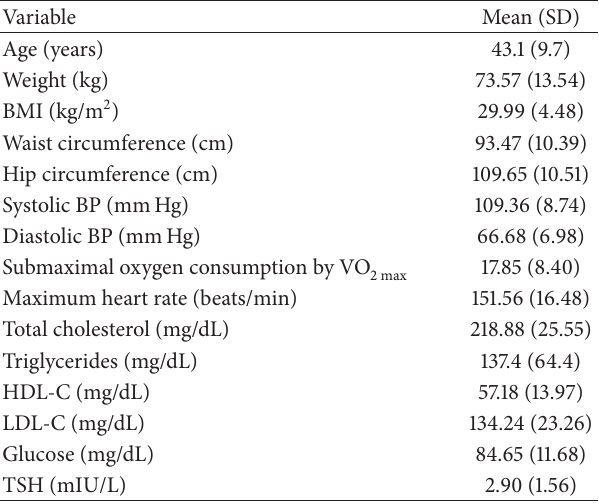
Table 1: Baseline characteristics in females with subclinical hypo- thyroidism.